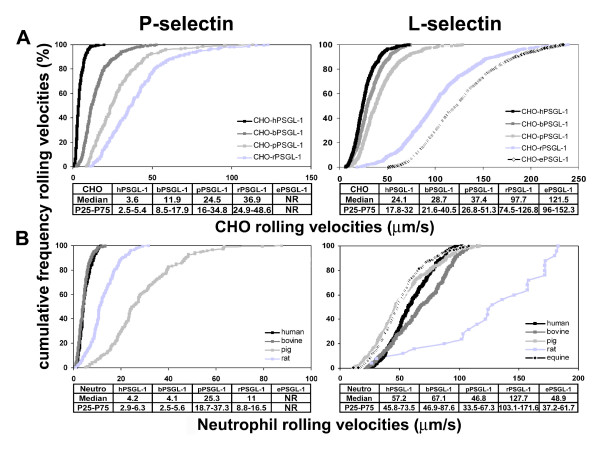
Rolling velocities of CHO-PSGL-1 transfectants or neutrophils on human L- or P-selectin. (A) CHO cells expressing human, bovine, pig, rat or equine PSGL-1 or (B) neutrophils were perfused under a constant shear stress on recombinant human P-selectin (1.5 dynes/cm2) or L-selectin/μ chimera (1.0 dyne/cm2). Cell velocities were measured at 4–5 min of perfusion. Curves were constructed in (A) using 183–755 or (B) 25–381 independent determinations of cell-rolling velocities and are representative of three experiments. Median rolling velocities, representative of 3 experiments, are indicated.